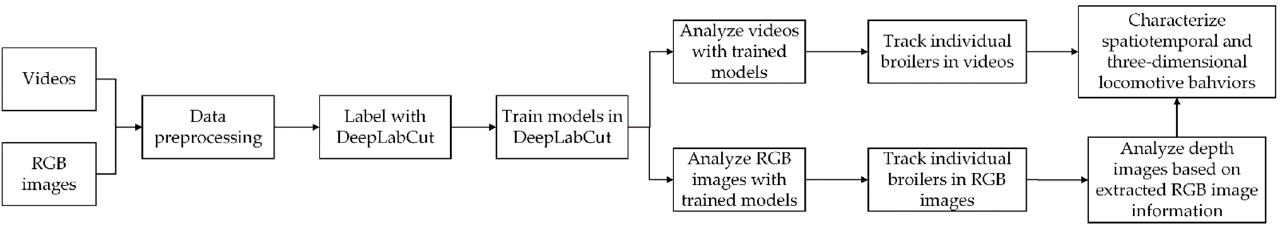
Figure 1. Overall process for tracking and characterizing spatiotemporal and three-dimensional locomotive behaviors of broilers.